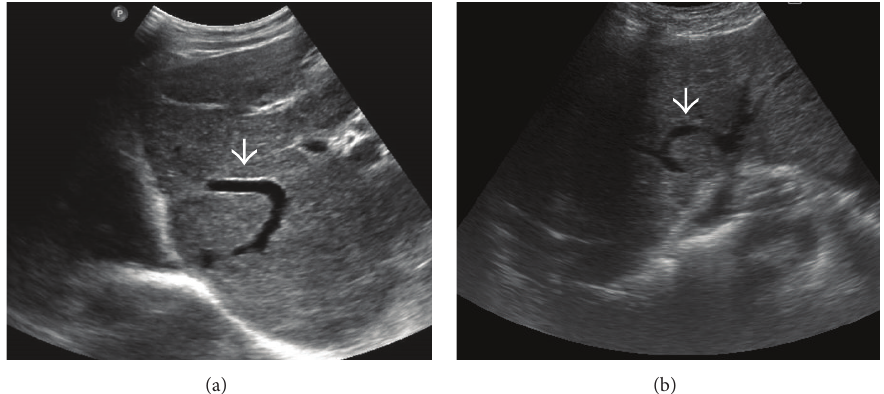
Figure 25: Other examples of comma-shaped collaterals (arrows) on